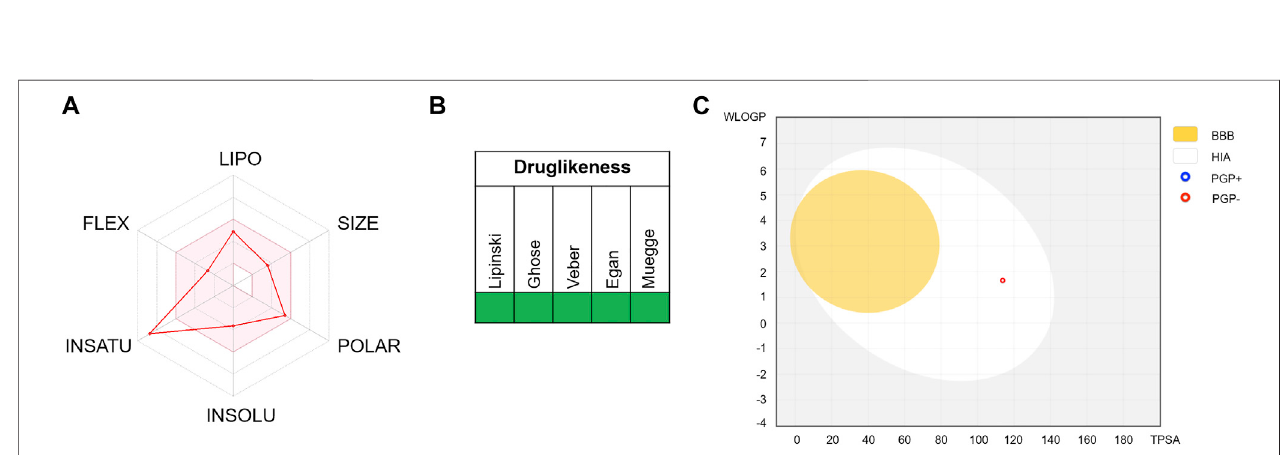
FIGURE 8 | ADME evaluation of HC-056456 was carried out by SwissADME (A) Bioavailability radars (B) Druglikeness assessment (C) Boiled-Egg model assessment.